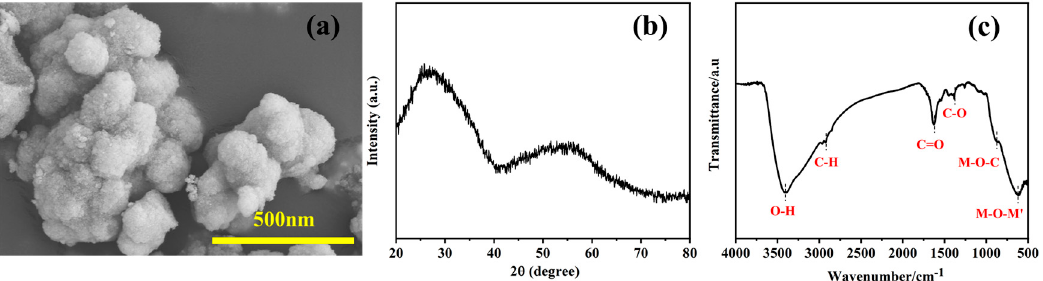
Figure 2. ( a ) SEM image, ( b ) XRD pattern, and ( c ) infrared spectrum of the precursor powder obtained by the solvothermal method.